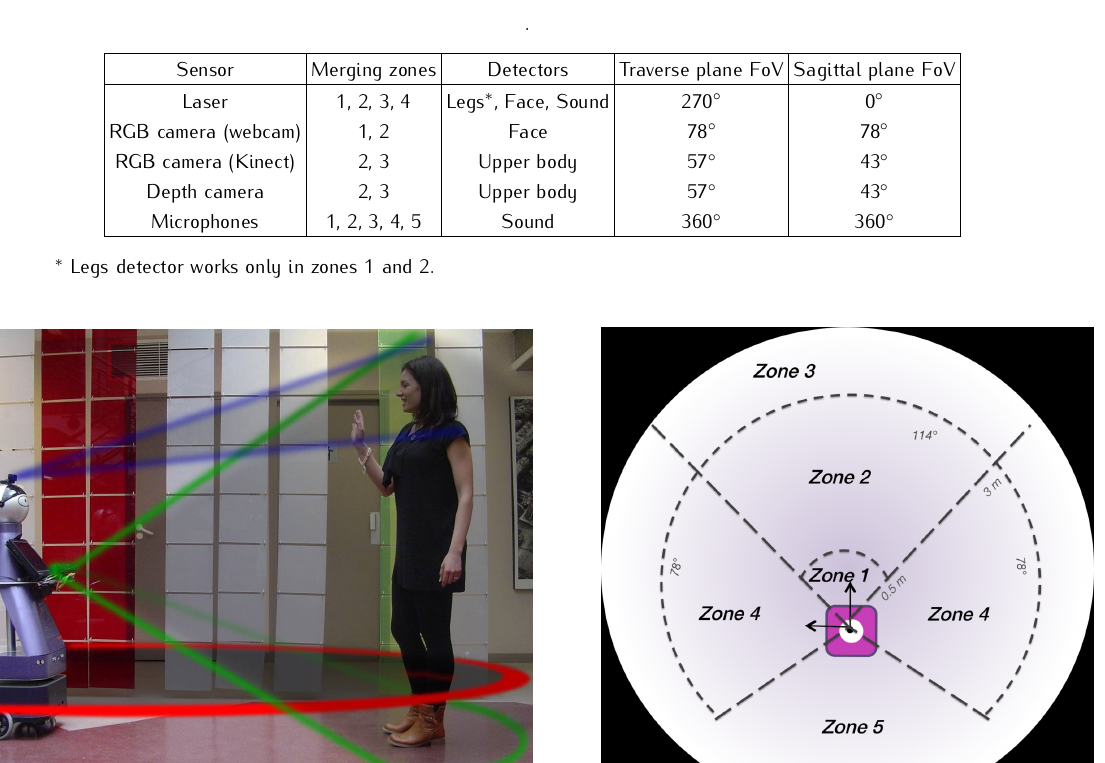
Table 1. Sensors used for human detection: merging zones (Figure 3) where their result is taken into account, detectors based on them and FoVs in traverse and sagittal planes.